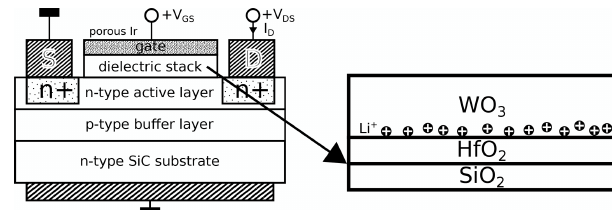
Figure 1. Schematic of the used FET structure adapted from An- dersson et al. (2013) highlighting the dielectric stack and the polar- ization effect with a positive V GS . The schematics are not to